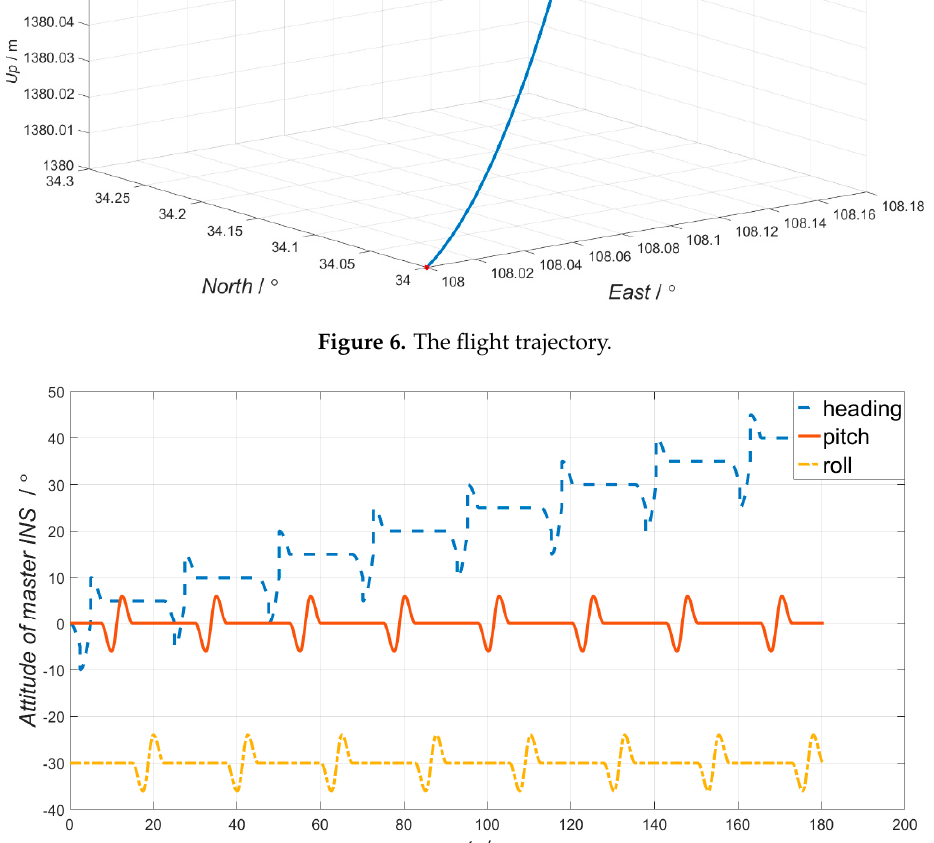
Figure 7. The attitude of master INS.